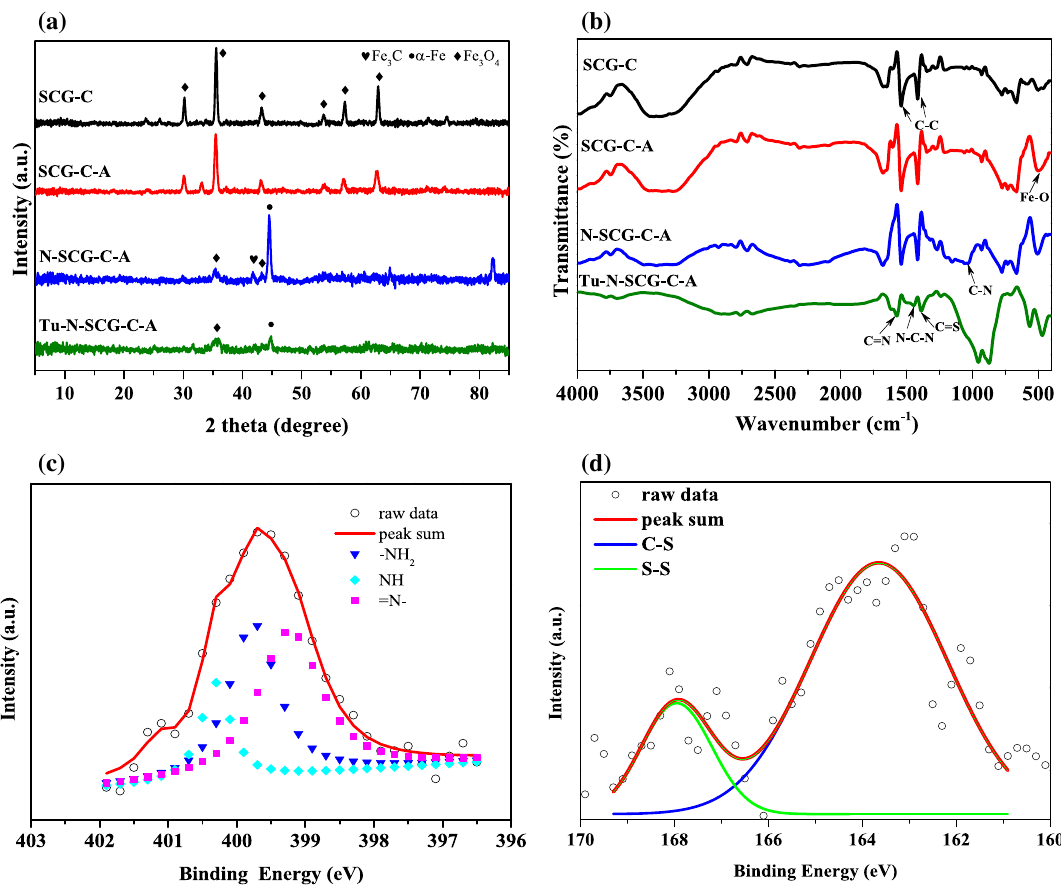
Figure 1. ( a ) X-ray diffraction patterns, ( b ) FTIR spectra of various samples, ( c ) XPS N 1 s and ( d ) S 2 p spectra of